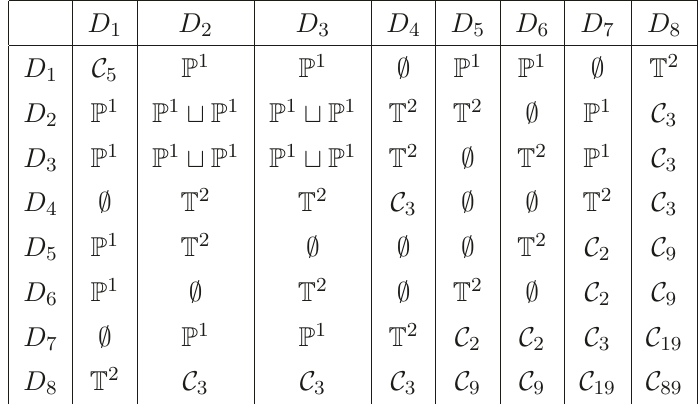
denotes a curve with Hodge C g